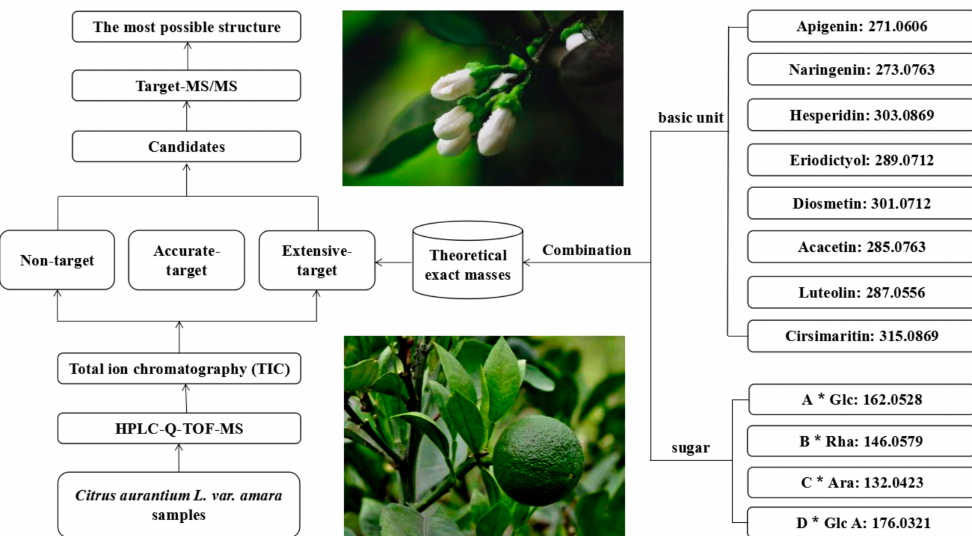
Figure 1. The diagram for systematic screening the secondary metabolites by high performance liquid chromatography / quadrupole time-of-flight mass spectrometry (HPLC-Q-TOF-MS) combined with a screening method. A, B, C, and D represent the number of glucose (Glc), rhamnose (Rha), arabinose (Ara), and glucuronic acid (Glc A), respectively and the number of sugars is no more than 3 according to previous